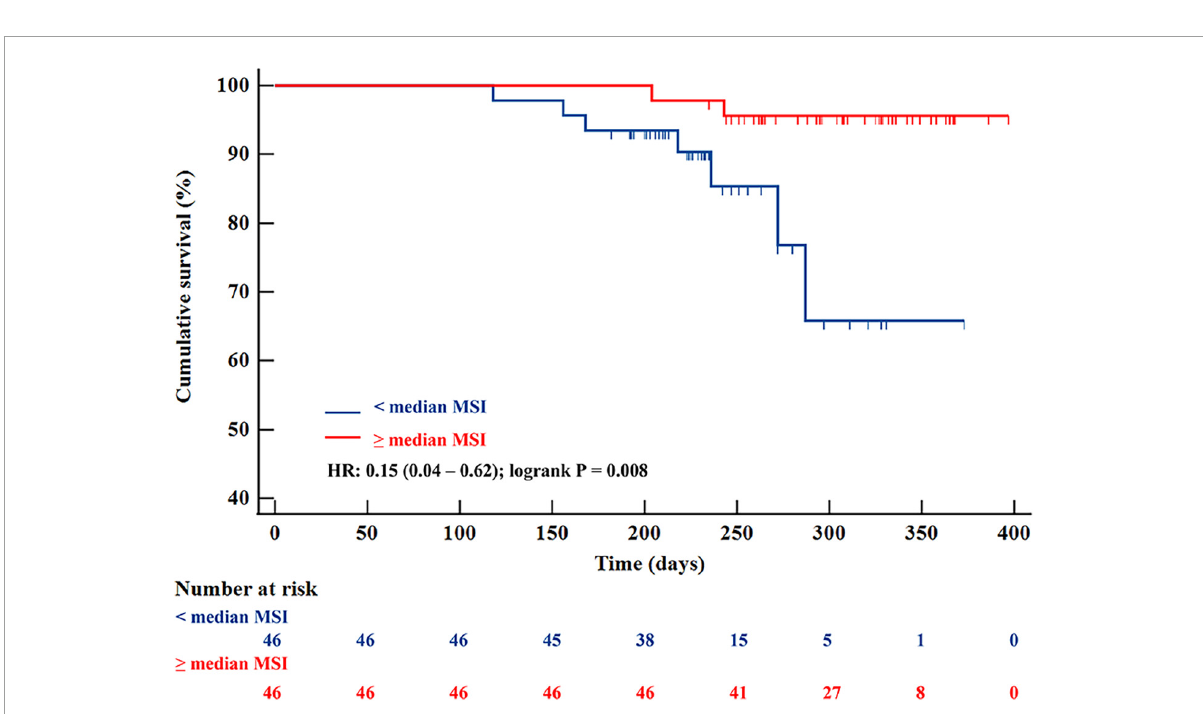
FIGURE4 Kaplan-Meier survival curves for 92 patients with STEMI separated into two groups according to median MSI. STEMI, ST-segment elevation myocardial infarction; MSI, myocardial salvage index.